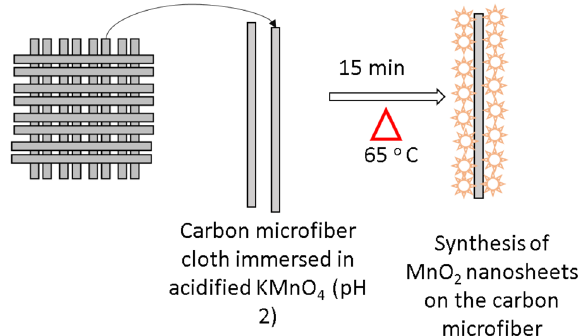
Figure 1. The synthesis process of the new catalyst (MnO 2 coated carbon